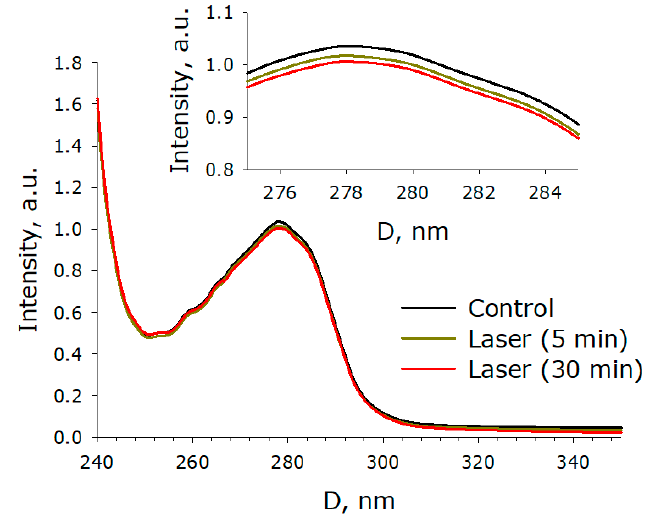
Figure 4. Effect of laser irradiation time on the optical density of an aqueous solution of BSA ( n = 6–8, mean). The upper inset presents an enlarged view of the change in optical density in the region of the local maximum at 280 nm. The data were obtained using sub-nanometer differential two-beam spectroscopy.